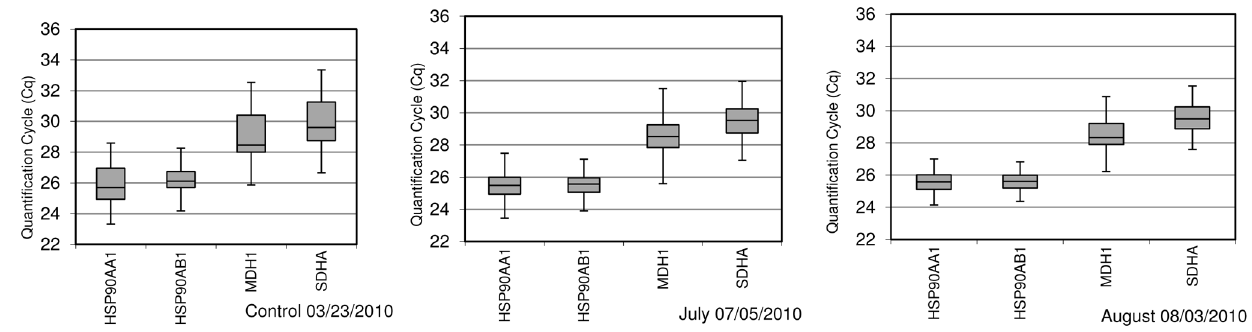
Figure 4. Distribution of Quantification Cycle (Cq) values for the target gene HSP90AA1 and the reference genes HSP90AB1 , MDH1 and SDHA . They were obtained by qPCR from samples collected at three different time points (Control, July and August) along the year. Boxes show the range of Cq values within each gene and treatment; the centre line indicates the median; extended vertical bars show standard deviation of the